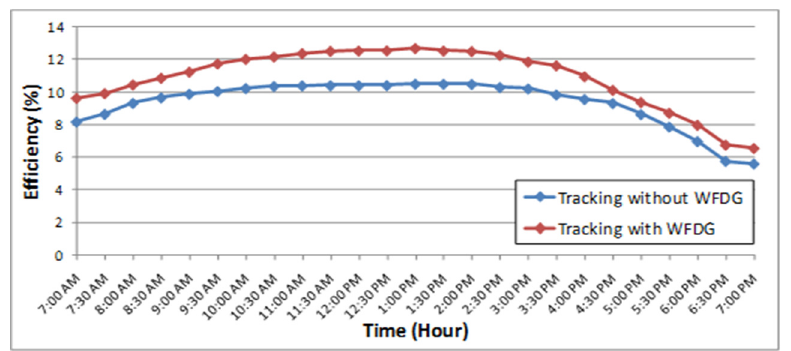
Fig. 9. Panel output power through day time.